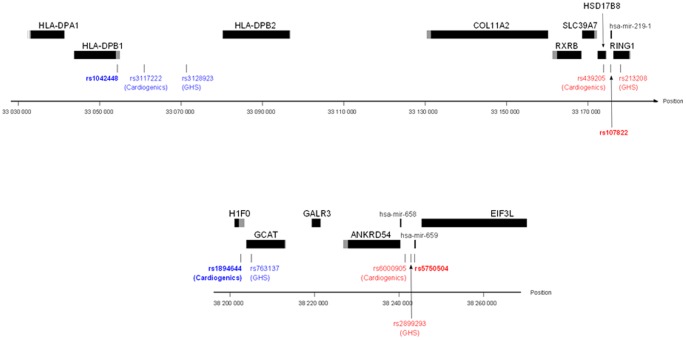
Location of genes, miSNP and 3'UTR SNPs at the two detected interacting loci.Gene are indicated as black rectangles with grey 3'UTR. Bold red and blue SNPs represent miSNPs and 3utrSNPs respectively. Corresponding proxies are non-bold coloured. Top: HLA-DBP1 locus on chromosome 6; Bottom: H1F0 locus on chromosome 22.